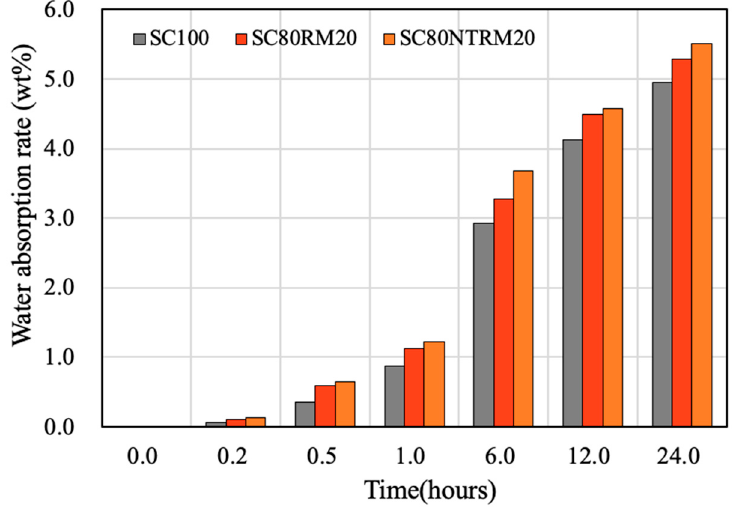
Figure 9. Water absorption rates of SC100, SC80RM20, and SC80NTRM20.